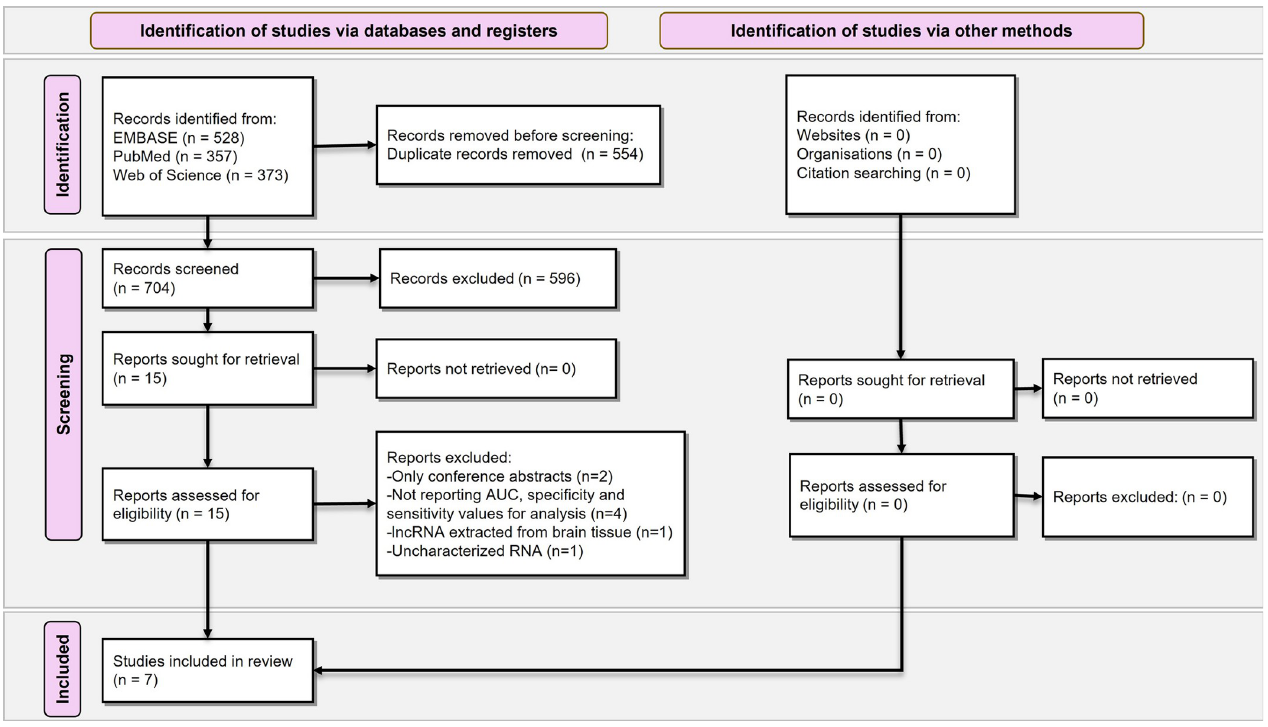
Fig 1. Flow chart of systematic review according to Preferred Reporting Items for Systematic Reviews and Meta-Analysis (PRISMA) guideline.